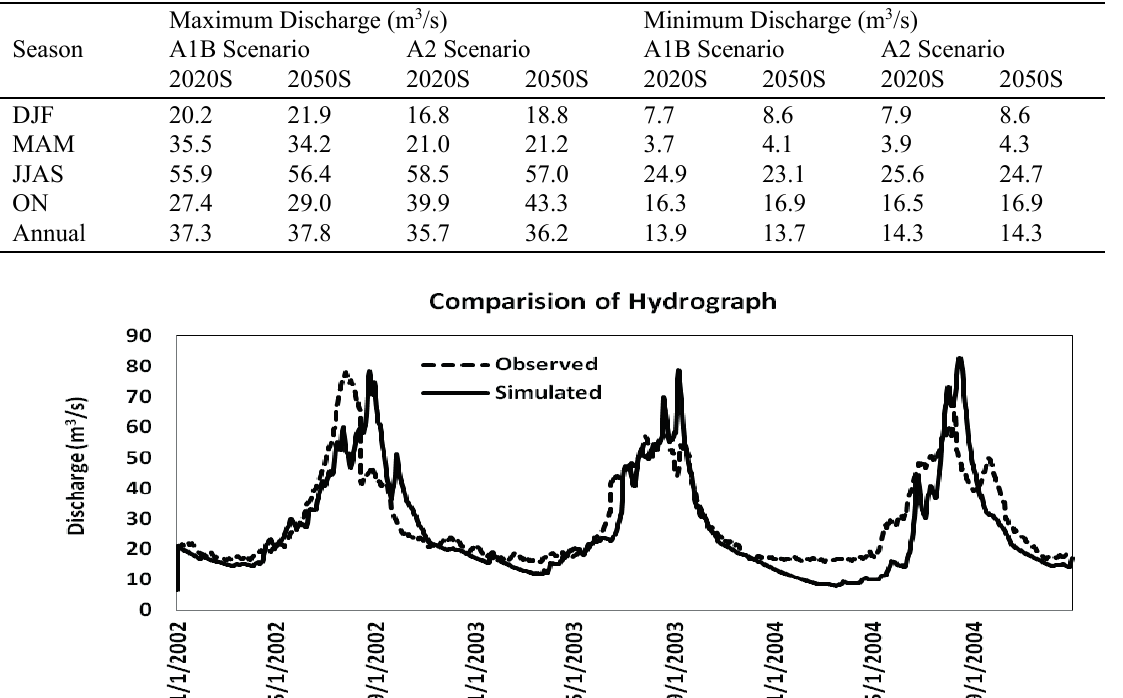
Fig. 2 Discharge calibrated hydrograph of Langtang